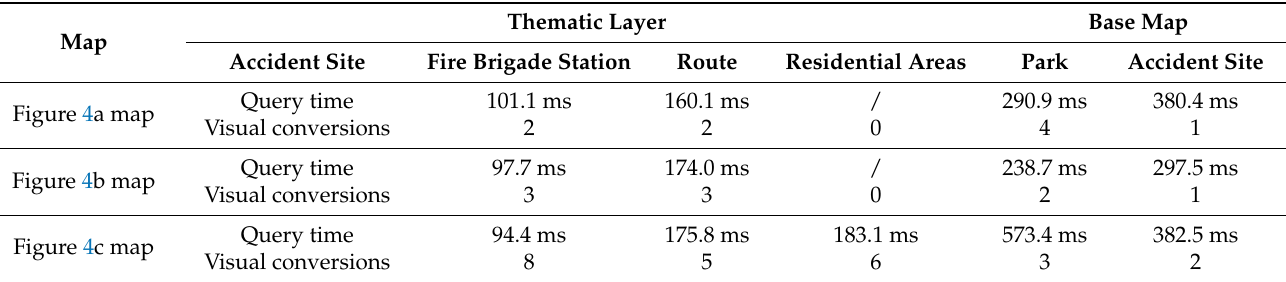
Table 2. Query time of cartographic objects and visual